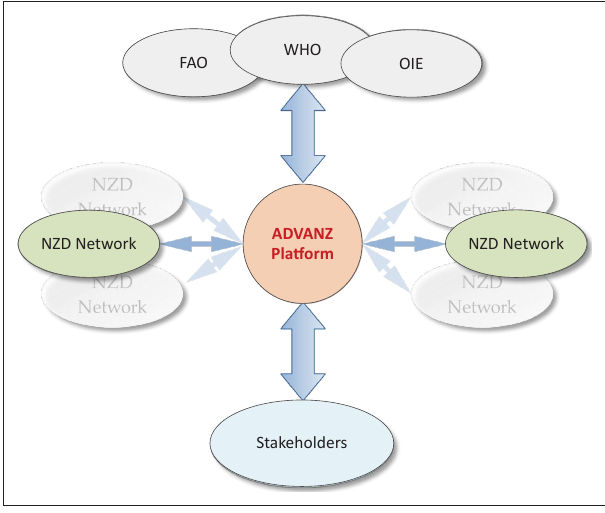
FIGURE 1: Proposed structure of the Pan-African One Health platform (ADVANZ) for neglected zoonotic diseases.